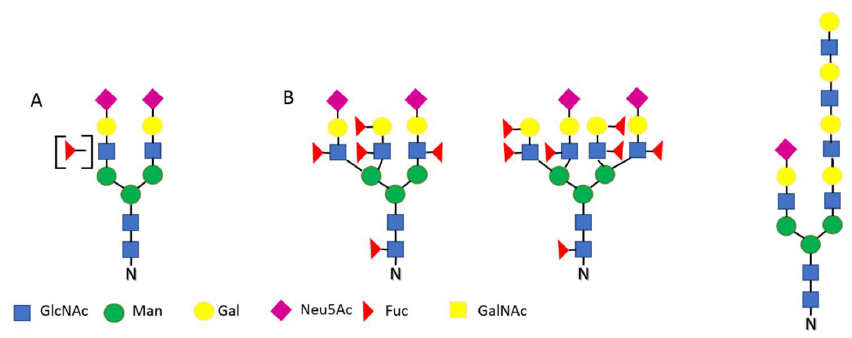
Figure 1. Examples of typical N-glycan structures; ( A ) dominant in healthy human serum, ( B ) com- mon disease-related structures.